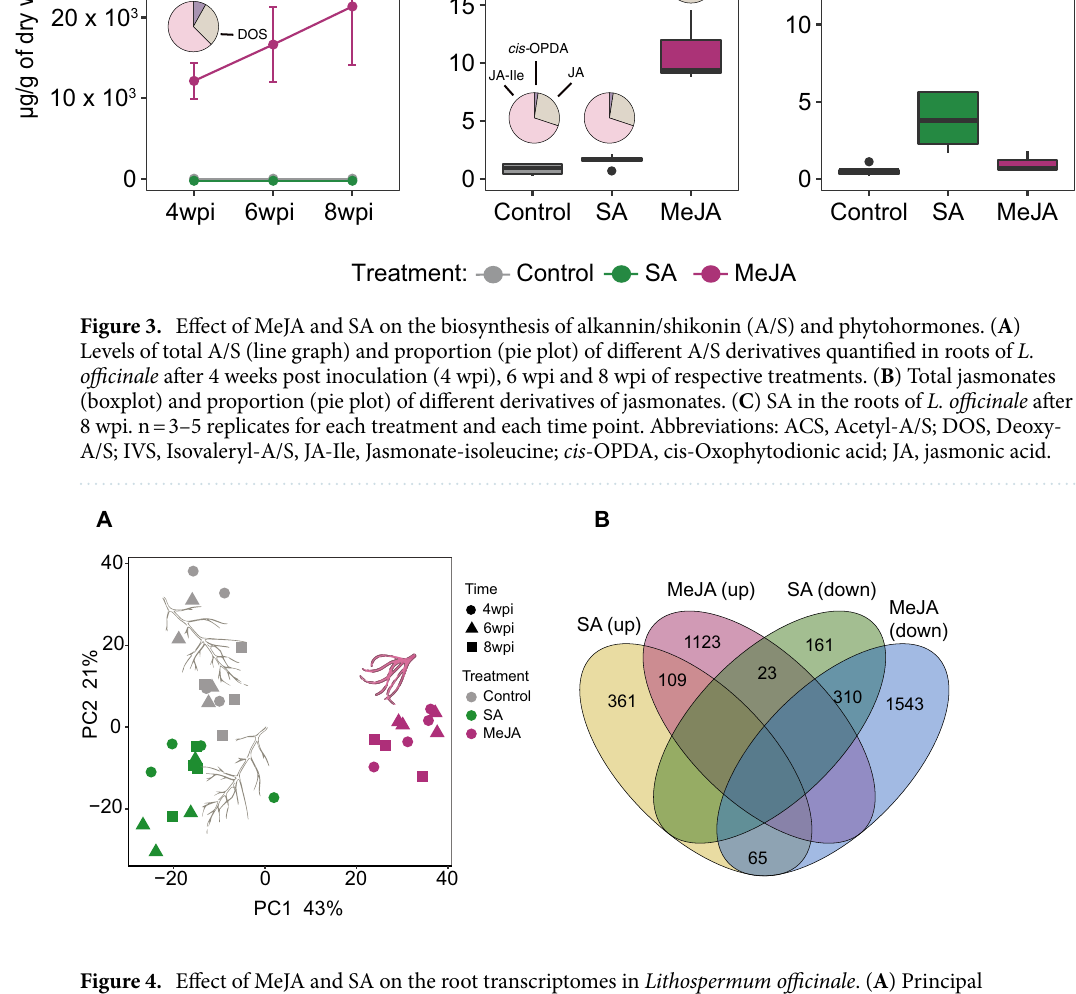
Figure 4. Effect of MeJA and SA on the root transcriptomes in Lithospermum officinale . ( A ) Principal component analysis of transcriptional variation of phytohormone treated roots. ( B ) Common and unique up- and down-regulated differentially expressed genes between MeJA and SA treatments in comparison to control